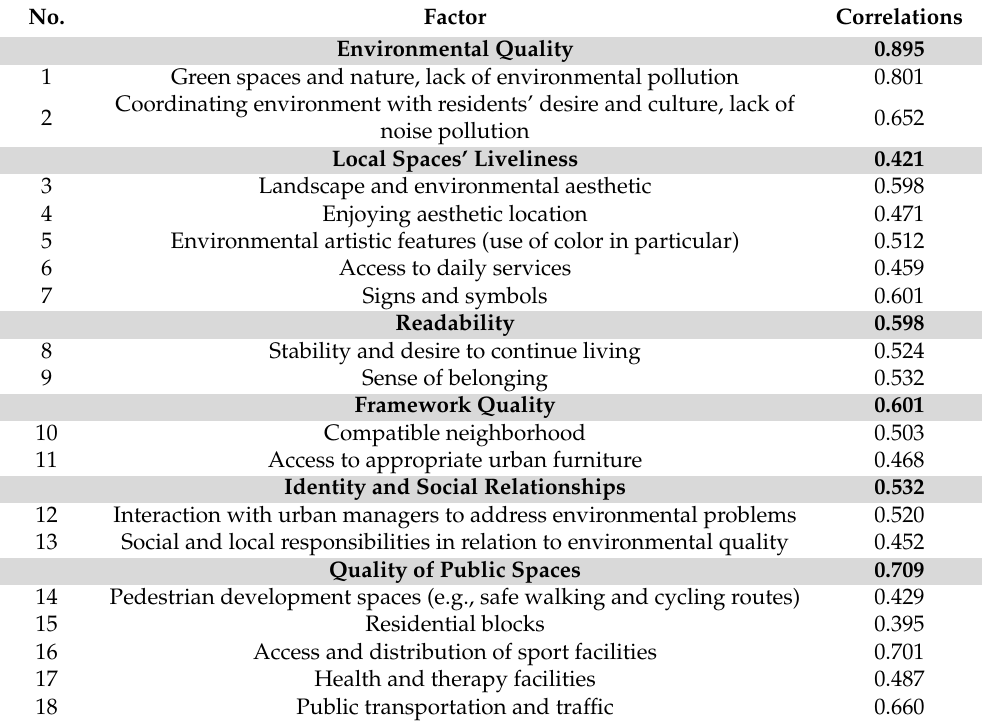
Table 4. Importance of environmental quality factors of region’s ecosystem